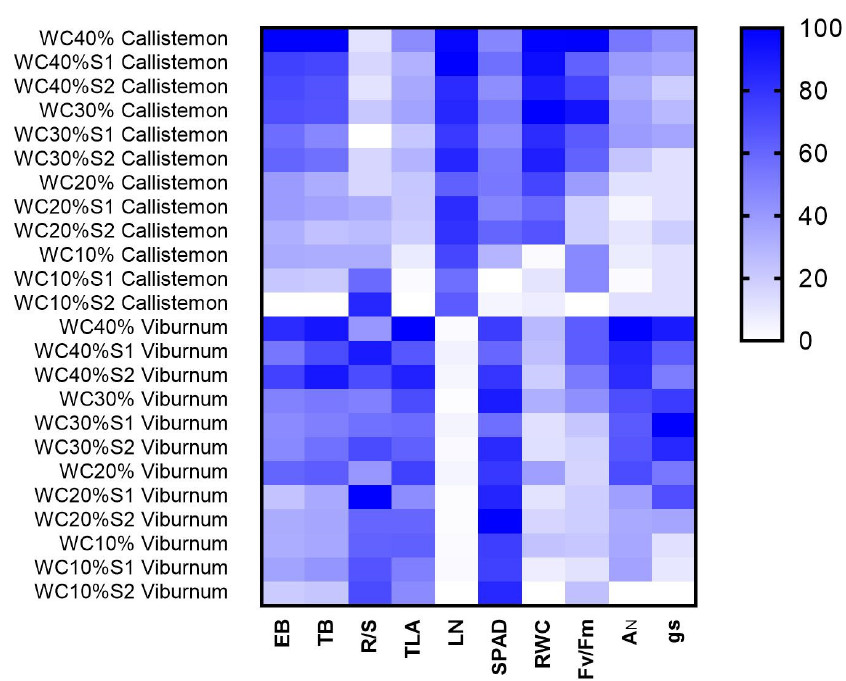
Figure 8. Heat map analysis summarizing the morphological and physiological changes of potted Callistemon and Viburnum plants responses to drought (WC 40%: control; WC 30%: light drought stress; WC 20%: moderate drought stress; WC 10% severe drought stress) and saline aerosol treatment (S0: Distilled water, S1: 50% Synthetic seawater solution, S2: 100% Synthetic seawater solution). Blue color indicates higher and white color indicates lower value. The mean values were normalized. TB = total dry biomass; EB = epigeous dry biomass; R/S = root to shoot ratio; TLA = total leaf area; LN = leaf number; SPAD = SPAD index; RWC = relative water content; Fv/Fm = maximum quantum efficiency of PSII; A N = net photosynthesis; gs = stomatal conductance.